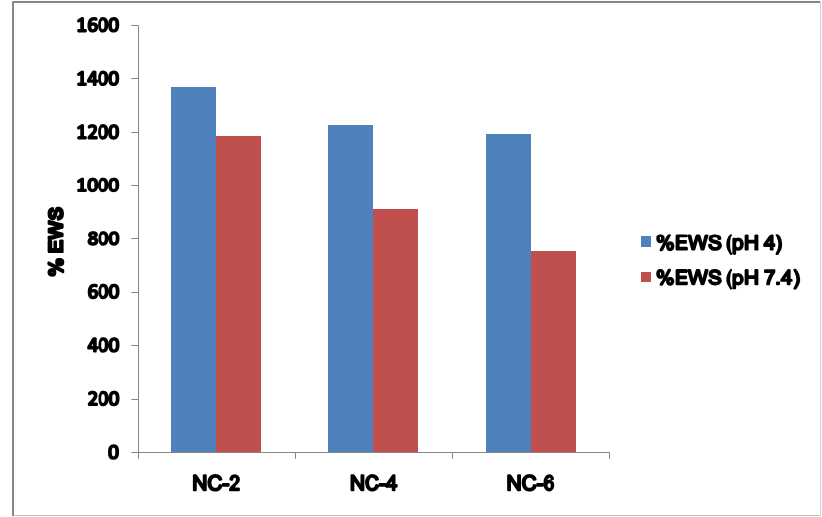
Figure 9. % EWS and pH relationship for the NCHs at pH 4 and pH 7.4.